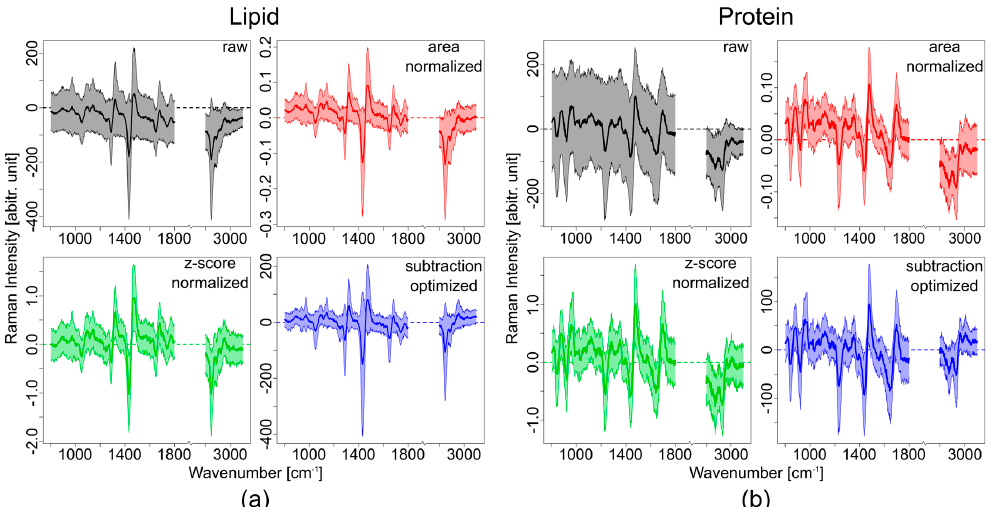
Figure 6. Comparison of different SERDS data processing methods with a 2 nm shift for ( a ) measured lipid spectra and ( b ) measured protein spectra. For every method the mean spectrum (darker shade) along with its standard deviation is shown. Black: difference spectra obtained by subtraction of raw data; red: difference spectra after area normalization; green: difference spectra after z-score normalization; blue: difference spectra after subtraction optimization.